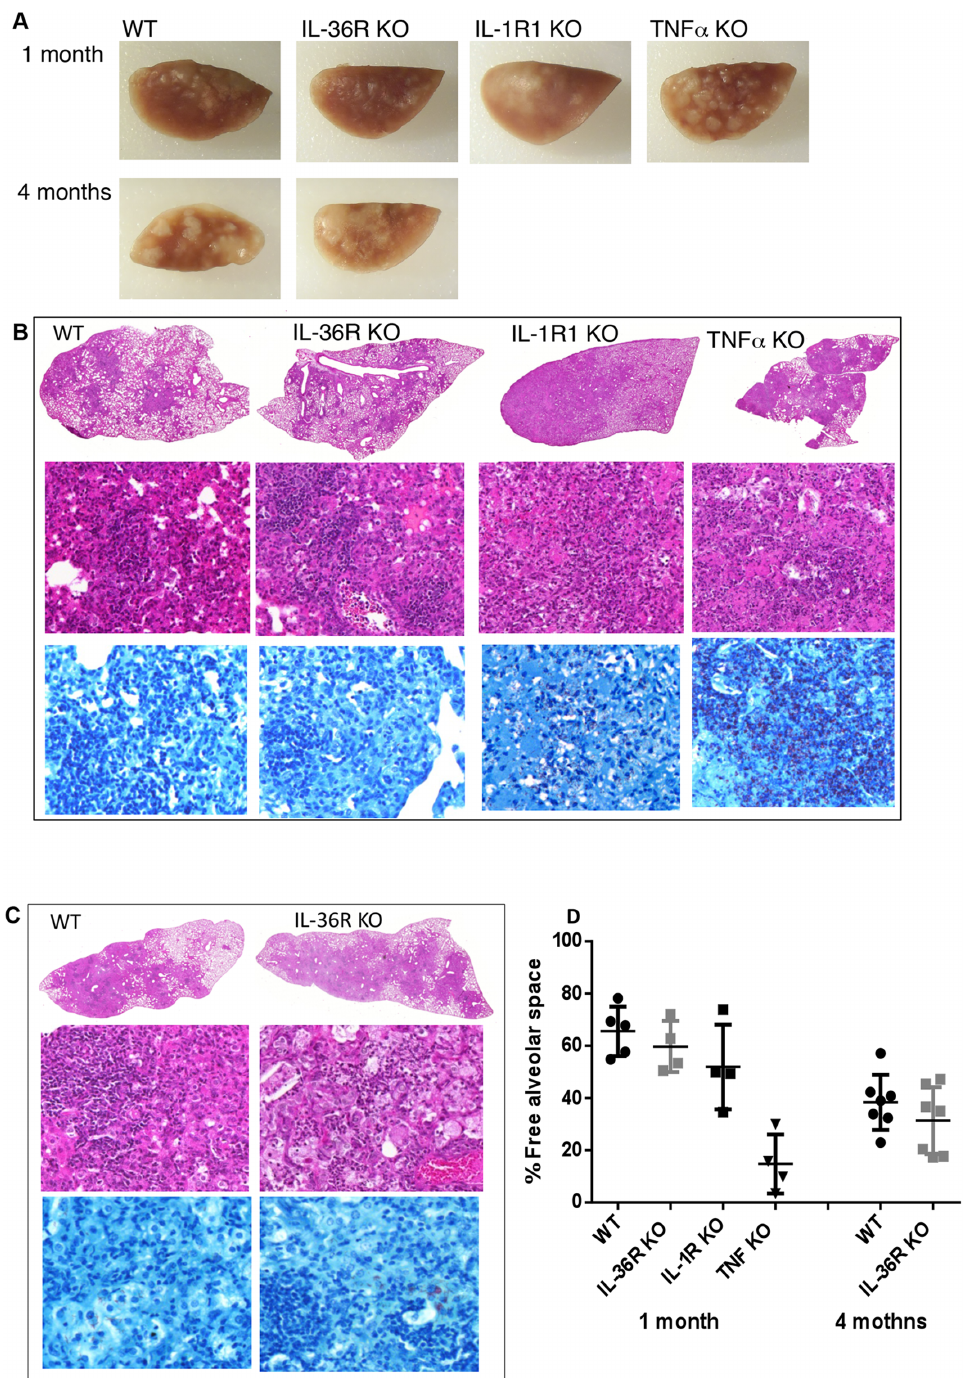
Fig 9. Controlled lung pathology after M . tuberculosis infection in the absence of IL-36R pathway. Macroscopic lung lesions of IL-36R deficient, IL- 1R1 deficient, TNF- α deficient, and WT mice at 1 month, and of IL-36R deficient and WT mice at 4 months post M . tuberculosis infection (A). Histological studies were performed at 1 month in IL-36R deficient, IL-1R1 deficient, TNF- α deficient, and WT mice (B), and at 4 months in IL-36R deficient and WT mice (C). Representative lung H&E (1x and 40x magnifications) and Ziehl-Neelsen (60x magnification) staining at 1 and 4 months post M . tuberculosis infection. Free alveolar space quantification is represented as the mean ± SD of percentage lung lesion free/total lung tissue in 4 – 7 mice per group with 1 – 2 lobes analyzed per mouse (D). Statistical analysis was one-way ANOVA, no statistically significantly differences were observed between animal groups.